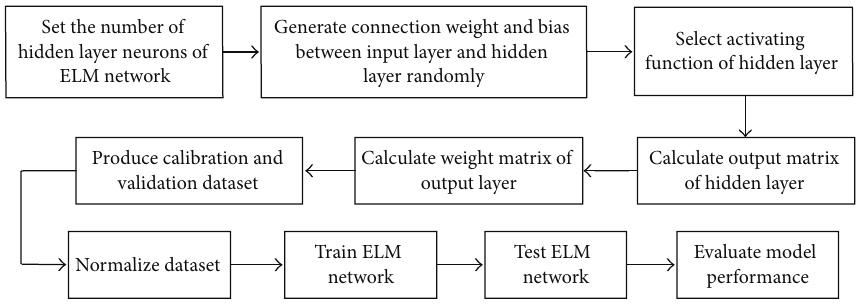
Figure 2: Flow chart of ELM algorithm on predicting classification.